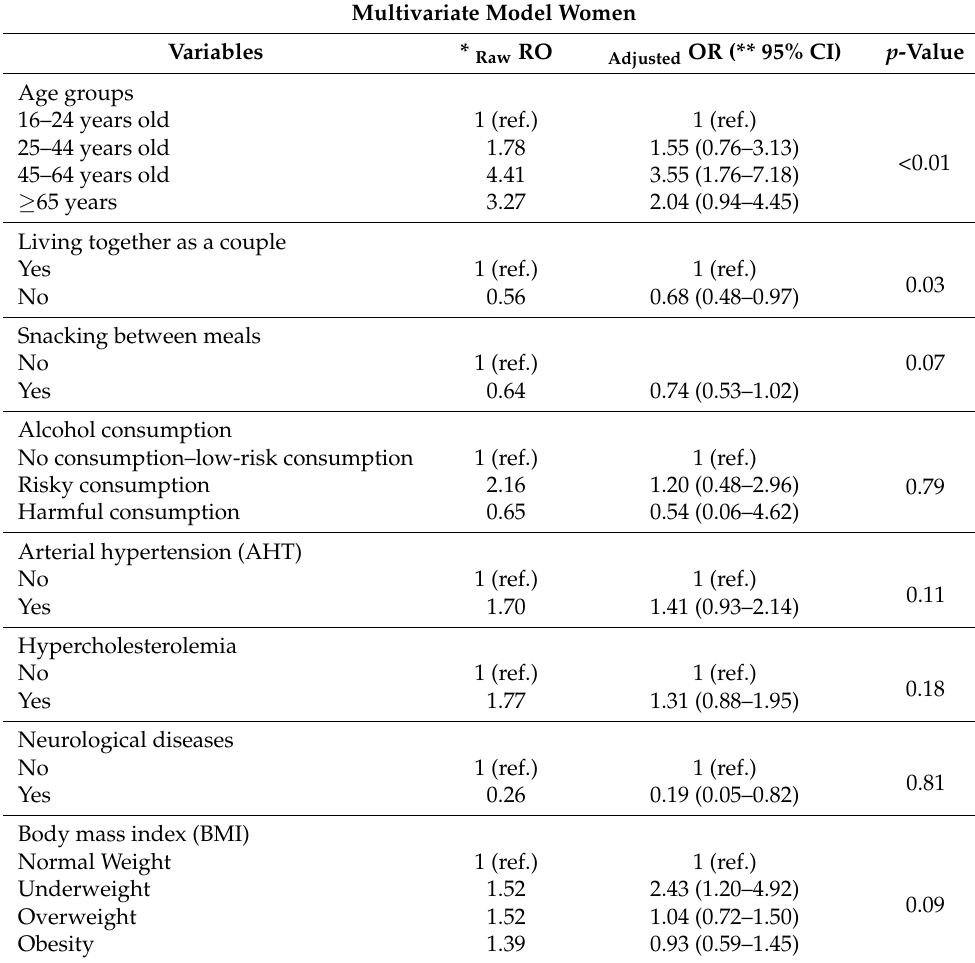
Table 7. Multivariate analysis of risk factors related to high adherence to the Mediterranean diet in adult women in southeastern